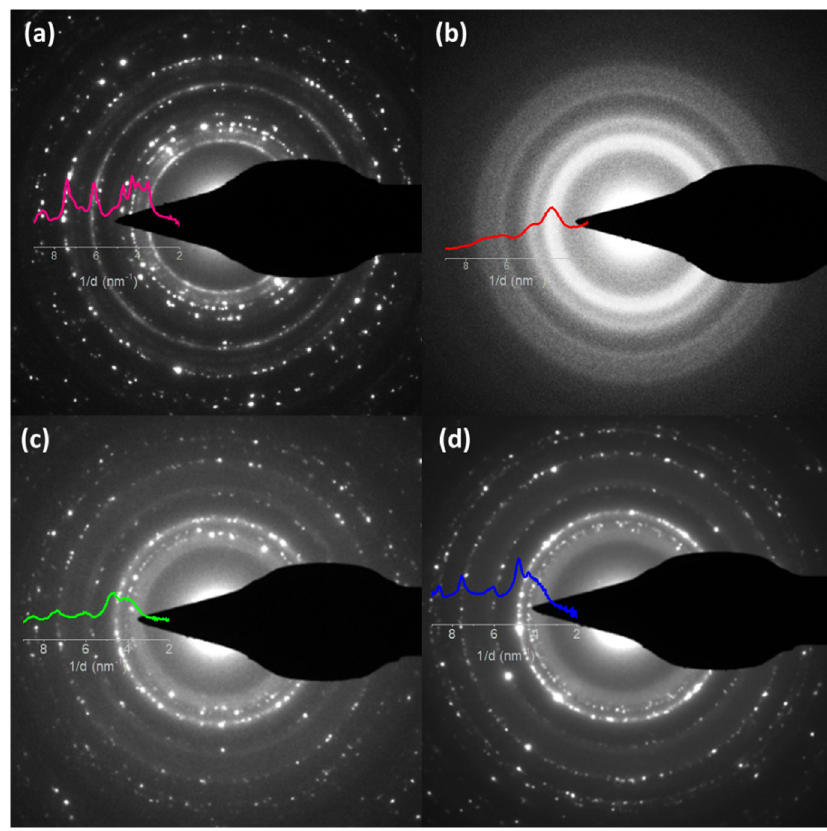
Figure 6. SAED images obtained for each coating: ( a ) pure Zn; ( b ) Zn-Fe alloy; ( c ) Zn NLs + Fe NPs; and ( d ) Zn-Fe NLs.